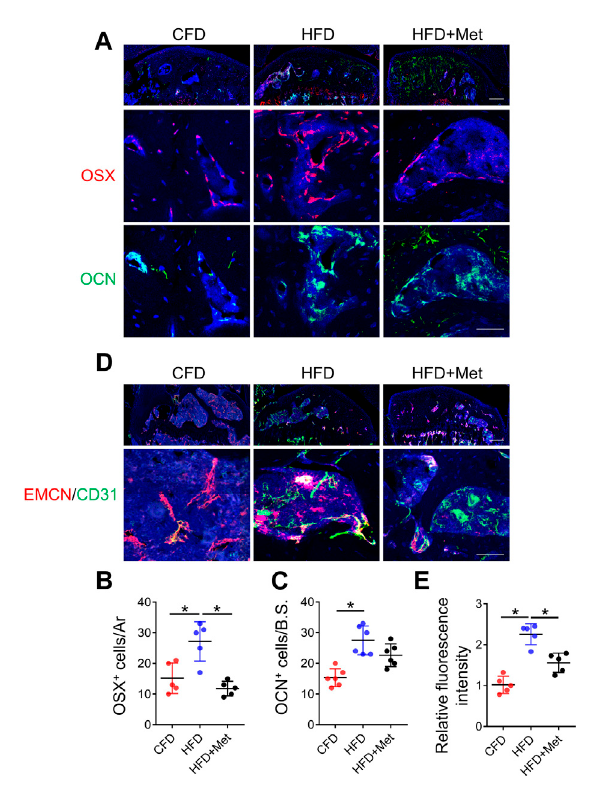
FIGURE 5 Metformin rescues aberrant vessel and bone formation in HFD- treated mice. Three-month-old C57BL/6 mice were fed a standard chow-food diet (CFD), HFD, or HFD with metformin (HFD + Met) for 3 months. n = 6 mice per group. (A – C) Immuno fl uorescence staining of knee joint tissue sections with antibody against Osterix (OSX, red) and osteocalcin (OCN, green) (A) , quanti fi cation of the number of OCN + cells in subchondral bone sections in (B) , and quanti fi cation of the number of OCN + cells in subchondral bone sections in (C) . (D – E) Immuno fl uorescence double staining of knee jointtissuesectionswithantibodyagainstendomucin(EMCN,red)and CD31 (green) (A) and quanti fi cation of the fl uorescence intensity of EMCN + CD31 + area in subchondral bone sections in (E) . All data are shown as means ± standard deviations. * p < 0.05. Statistical signi fi cance was determined by one-way